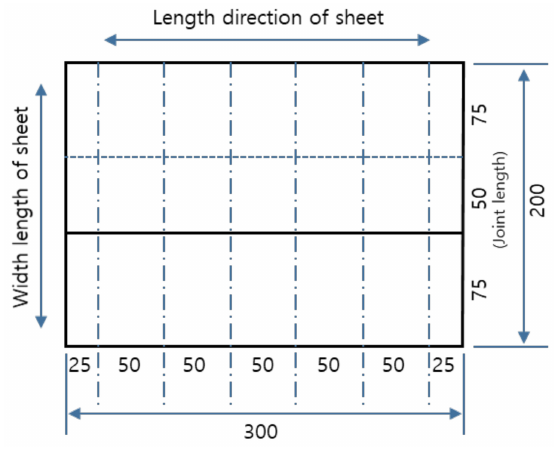
Figure 3. Fabrication of joint tensile performance test specimens (unit: